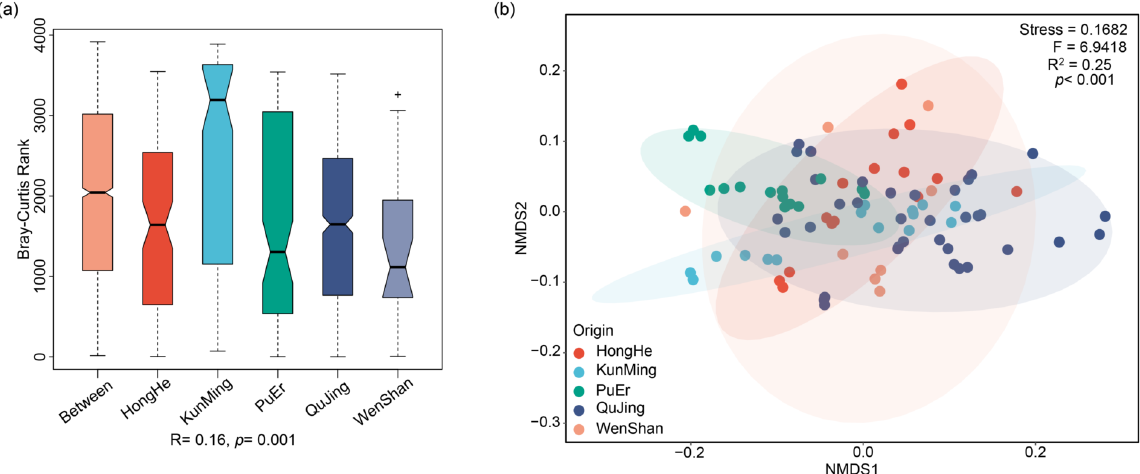
Figure 2. The results of ANOSIM and NMDS analyses of multi-element content of P. notoginseng from five origins. ( a ) The analysis of similarities (ANOSIM, using Bray–Curtis similarity distance matrix) of the multi-element content from five origins. ‘+’ represents outliers. ( b ) the results of the non-metric multidimensional scaling (NMDS, using the Bray–Curtis similarity distance matrix) of the multi-element content from five origins.